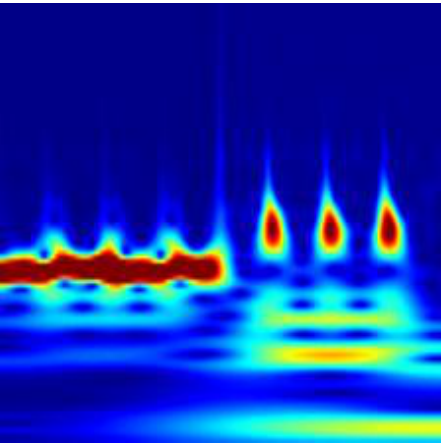
Figure 10. Time-frequency representation for the sine fault scenario.